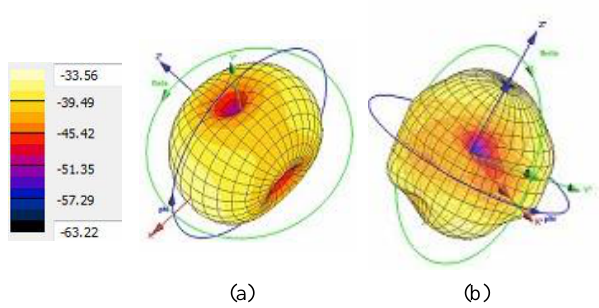
Figure 5. Radiation (3-D far field radiation pattern) performance [dBi] of the ingestible antenna (a) in the cubic model, (b) in the anatomical model.